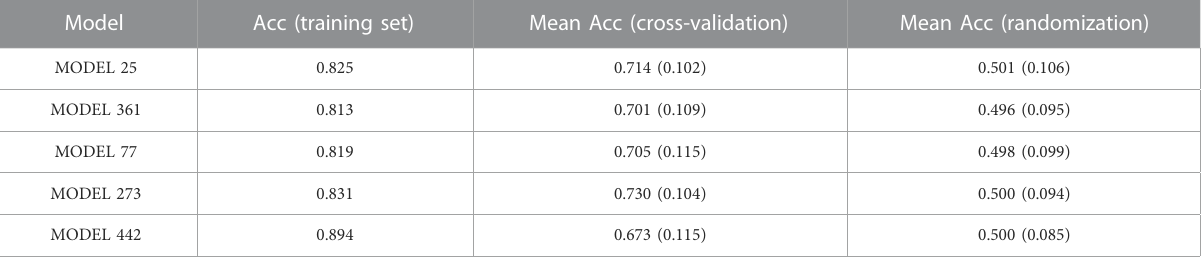
TABLE 2 Internal validation of the 5 best individual models in the fi rst retrospective screen. For the cross-validation and randomization tests, the mean accuracyacrossthe500roundsisinformed;thestandarddeviationofthemeanispresentedinparentheses.Themodelshavebeenorderedaccordingtotheir performance in the fi rst retrospective screening.